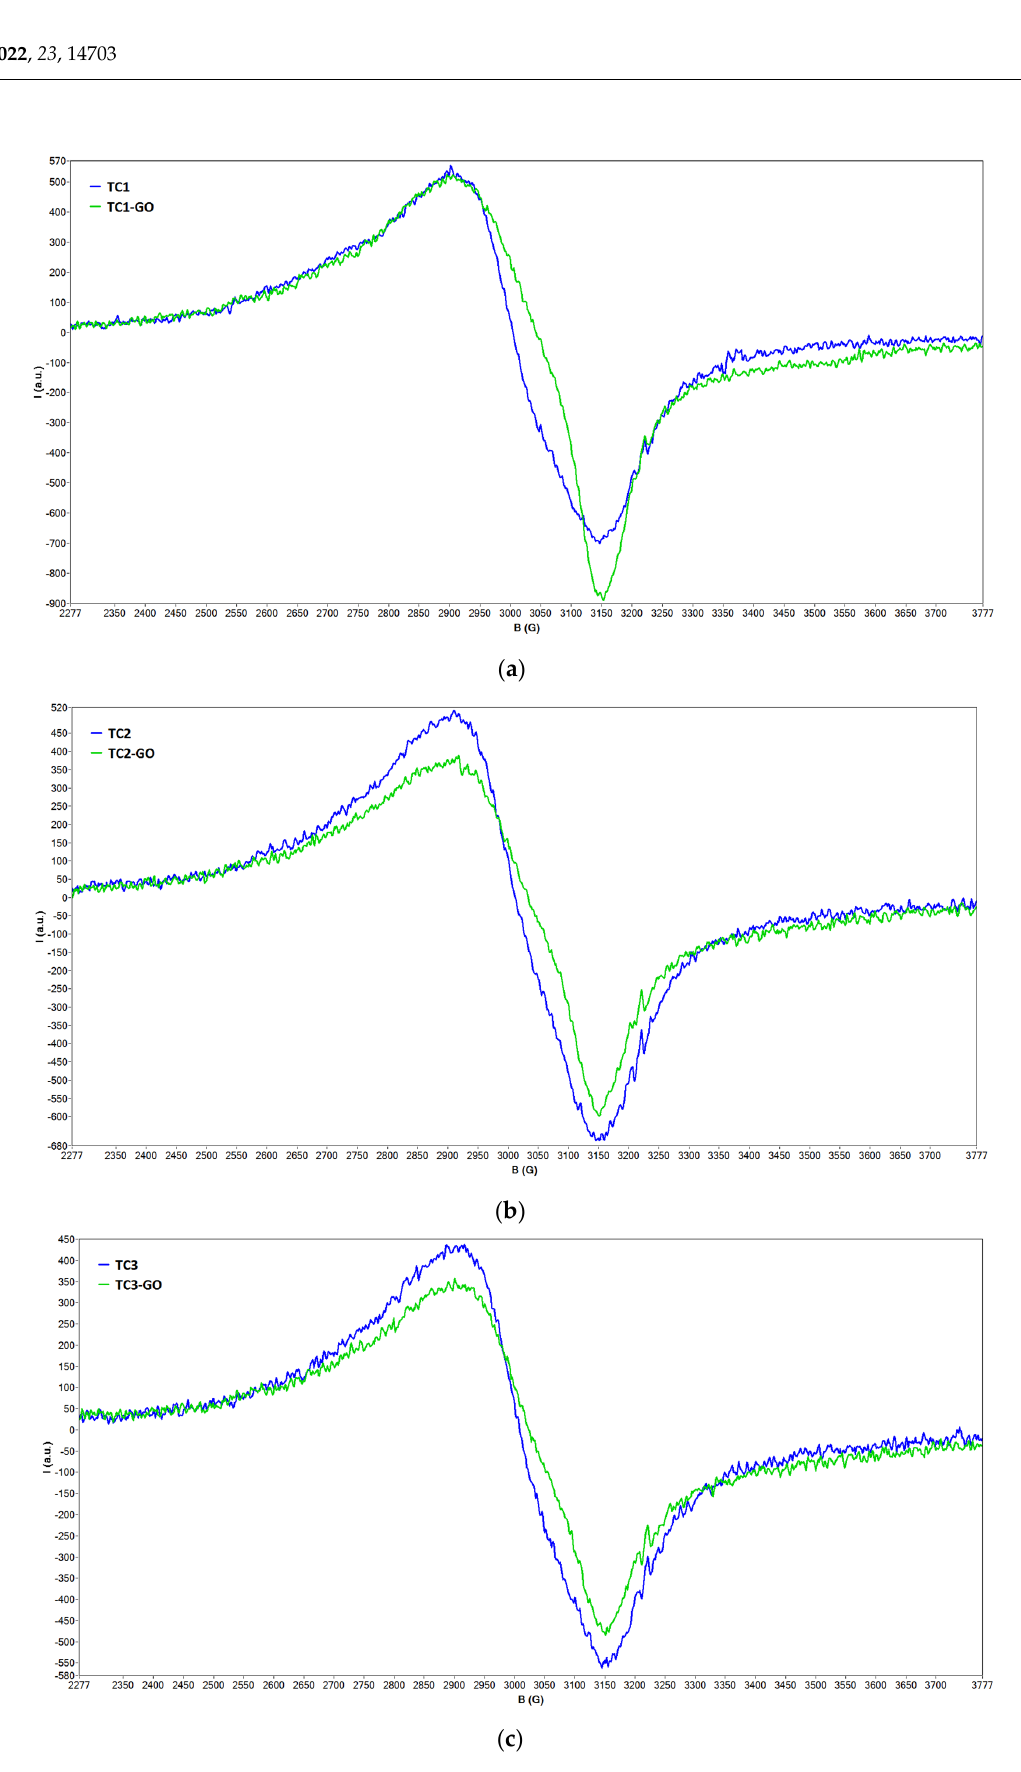
Figure 2. Solid state EPR spectra of the TC1/TC1-GO ( a ), TC2/TC2-GO ( b ), and TC3/TC3-GO pairs ( c ). Table 1. The g factors of the solid samples investigated.